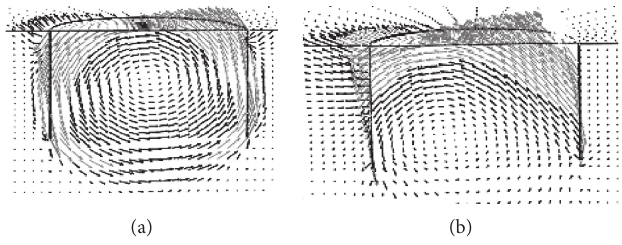
Figure 4: Failure mechanisms of bucket foundation. (a) Homogeneous. (b) Heterogeneous.